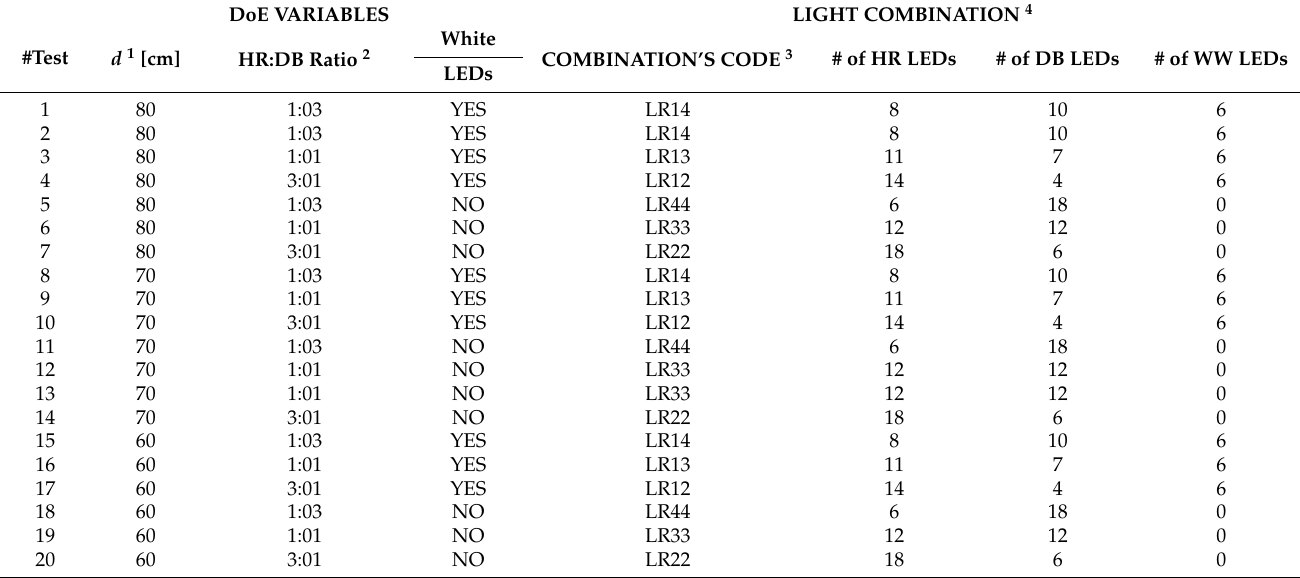
Table 6. Experimental